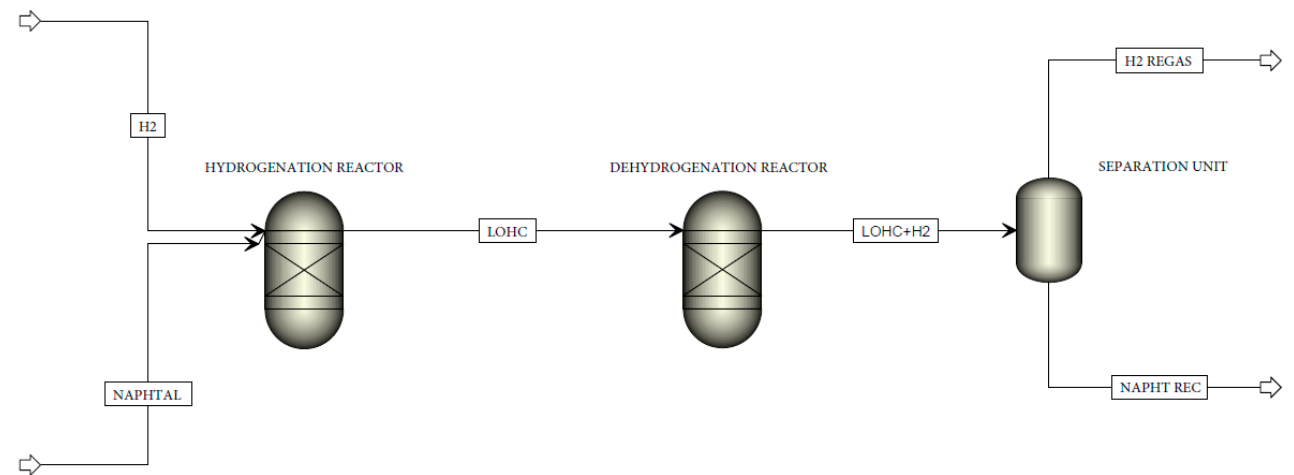
Figure 6. Simulated PFD for LOHC hydrogenation-dehydrogenation processes.